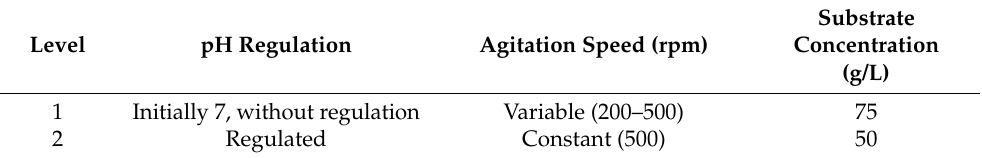
Table 2. Levels of factors used in the batch cultures of Y. lipolytica